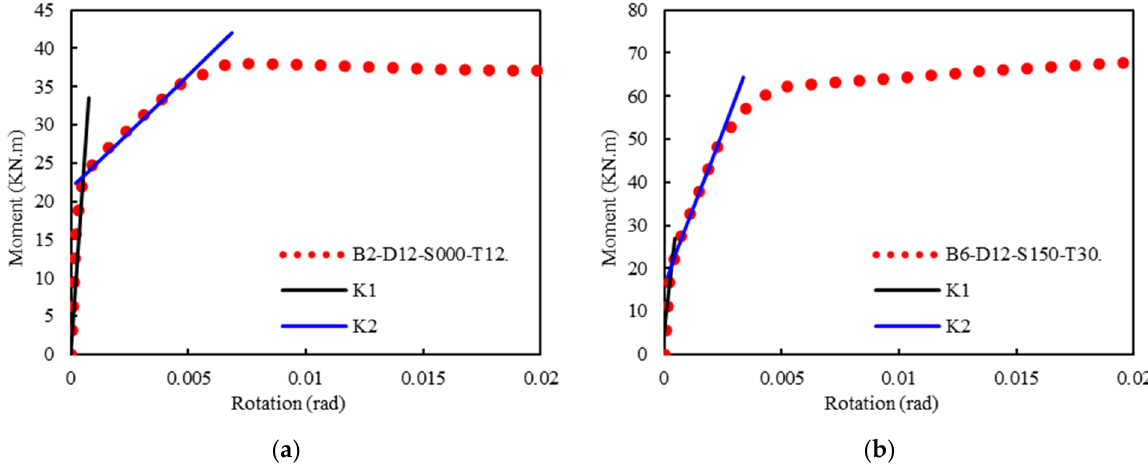
Figure 18. Piecewise linear idealization for specimens ( a ) B2-D12-S000-T12 and ( b ) B6-D12-S150-T30.